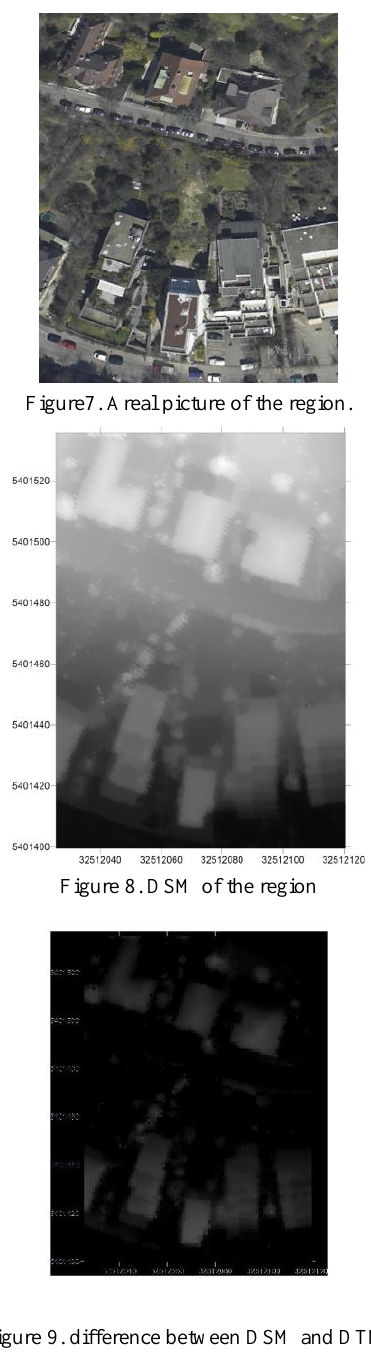
Figure 9. difference between DSM and